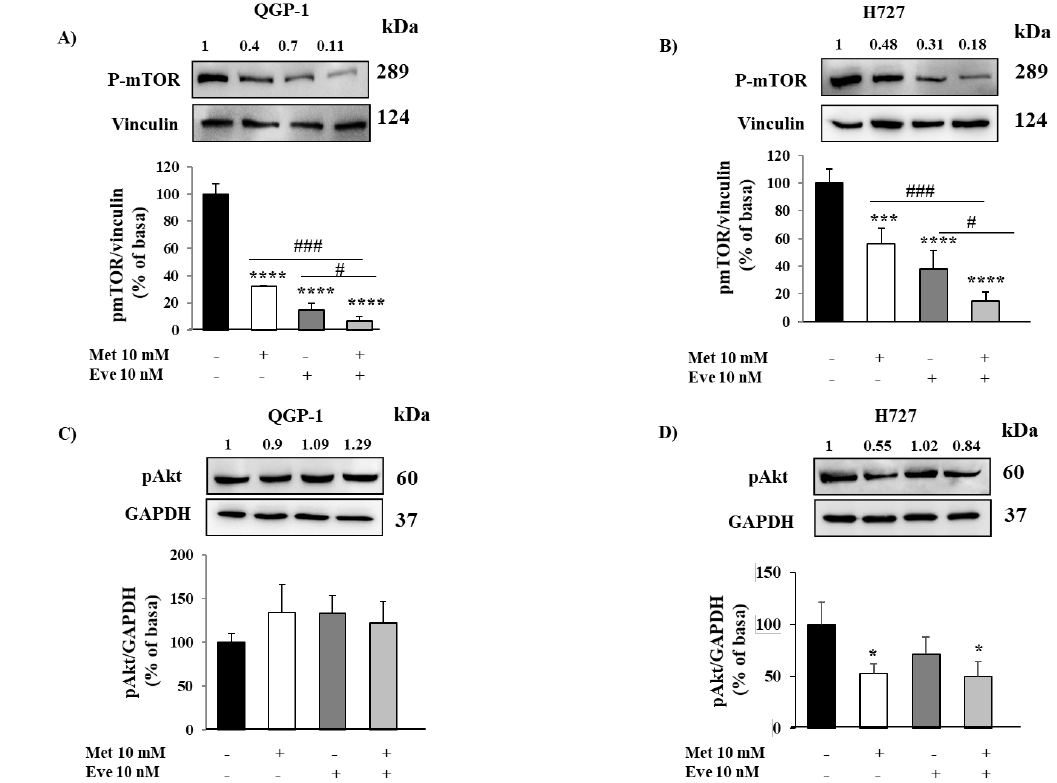
Figure 5. The e ff ect of metformin (Met) and everolimus (Eve) on mTOR and Akt phosphorylation in QGP-1 and H727 cells. ( A , B ) Representative immunoblots of phospho-mTOR demonstrating that the inhibition of mTOR by metformin and everolimus in combination is more potent than each monotherapy in both cell lines. The graph shows the quantification of phospho-mTOR normalized to the housekeeping gene vinculin (mean value ± SD from 3 independent experiments). *** = p < 0.001, **** = p < 0.0001 vs. corresponding basal and # = p < 0.05, ### = p < 0.001 vs. the single drug. Statistical analysis was performed with a one-way ANOVA test followed by Tukey’s post-hoc test. ( C ) Representative immunoblots of phospho-Akt demonstrating that metformin does not a ff ect Akt phosphorylation in the QGP-1 cell line. The graph shows the quantification of phospho-Akt normalized to the housekeeping gene GAPDH (mean value ± SD from 3 independent experiments). Statistical analysis was performed with a one-way ANOVA test followed by Tukey’s post-hoc test. ( D ) Representative immunoblots of phospho-Akt demonstrating that metformin significantly decreases Akt phosphorylation in H727 cell lines. The graph shows the quantification of phospho-Akt normalized to the housekeeping gene GAPDH (mean value ± SD from 3 independent experiments). * = p < 0.05 vs. corresponding basal. Statistical analysis was performed with a one-way ANOVA test followed by Dunnett’s post-hoc test. Unprocessed images for WB results see Figures S2 and S3.